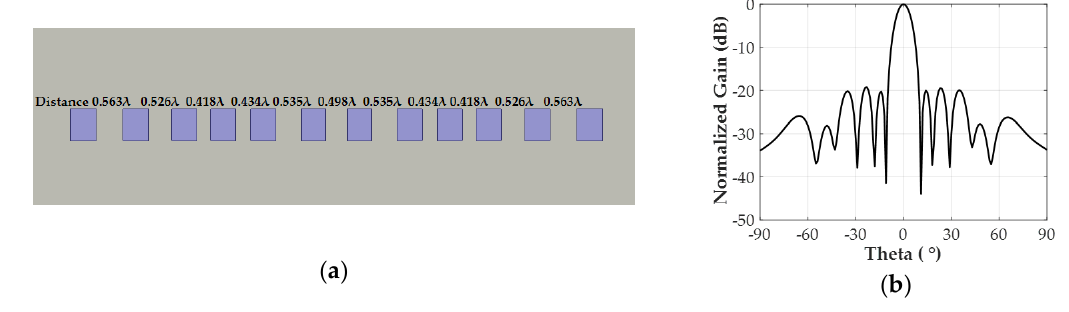
Figure 7. ( a ) Non-uniformly spaced 12-element patch array without a power divider. ( b ) Normalized gain of the non-uniformly powered and non-uniformly spaced patch array without a power divider in the simulation.